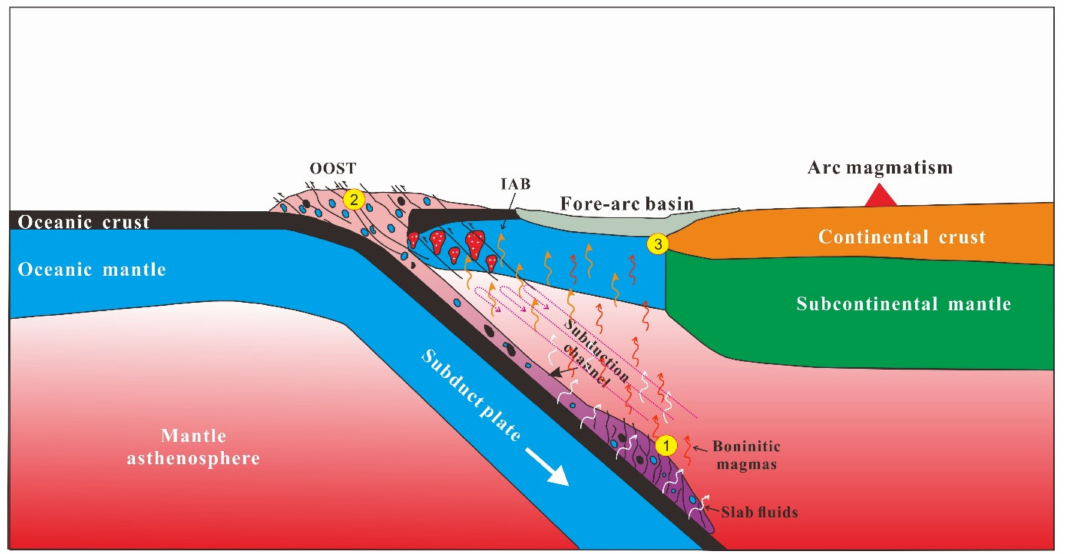
Figure 12. Tectonic model illustrating the possible environment of Raobazhai ultramafic complex (modified after [45]). OOST: out-of-sequence thrust; IAB: island arc